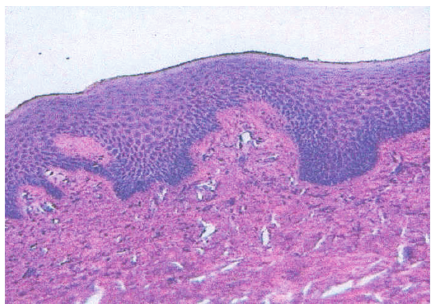
Figure 9: Microscopic